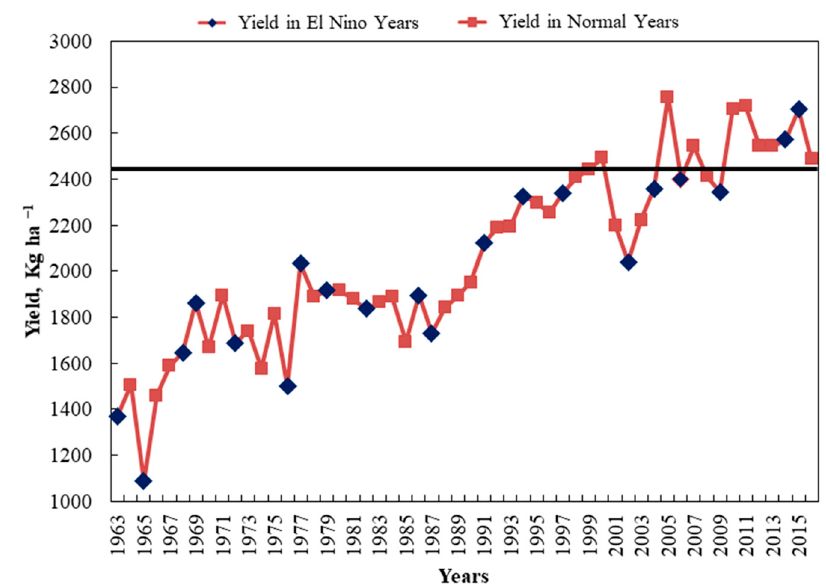
Figure 4. Average Kharif rice yield (kg ha − 1 ) in Karnataka (1963–2016).